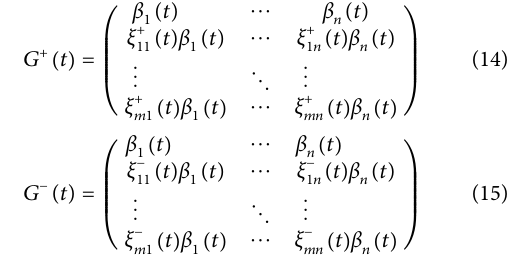
STEP 4: DETERMINETHEINDICATOR SET. Theuse ofANP to determine the index set requires the establishment of an ANP structure model, including the control layer and the network layer. Then, the index weight β j ( t ) is determined. The principle of the ANP weighted structure model (Sun et al., 2011) is shown in Figure 2. STEP 5: Calculate gray projection closeness. Considering the in fl uence of the index set weights on the original coef fi cient matrix, let G + ( t ) (cid:1) β j ( t ) E + ( t ) , G − ( t ) (cid:1) β j ( t ) E − ( t ) , expand to obtain the two benchmark-weighted gray correlation coef fi cient